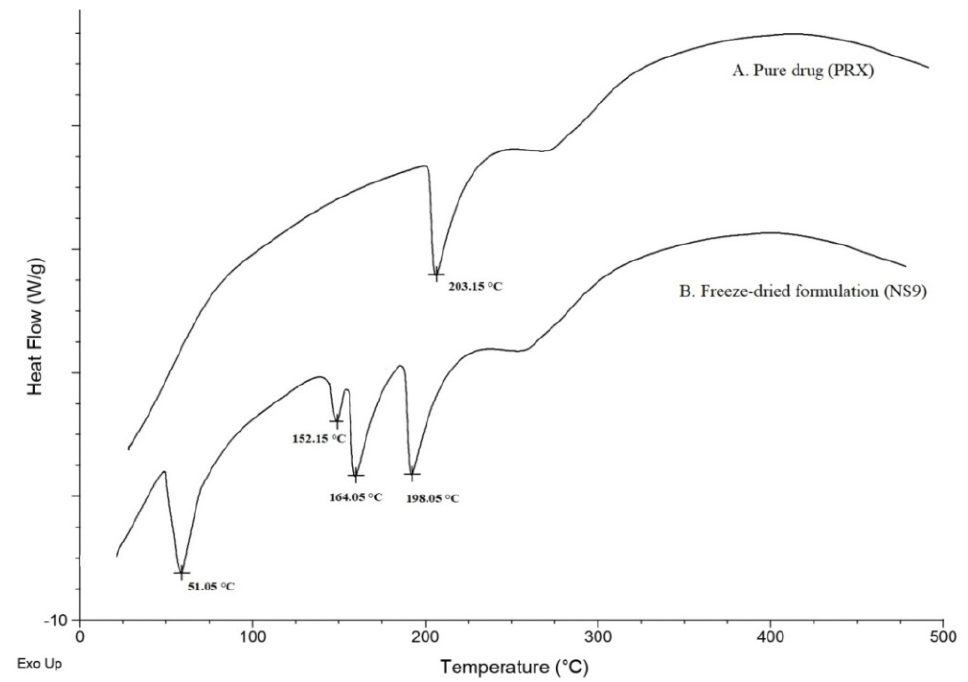
Figure 6. Overlain DSC thermograms of the pure drug (PRX) (A) and freeze-dried formulation (NS9)